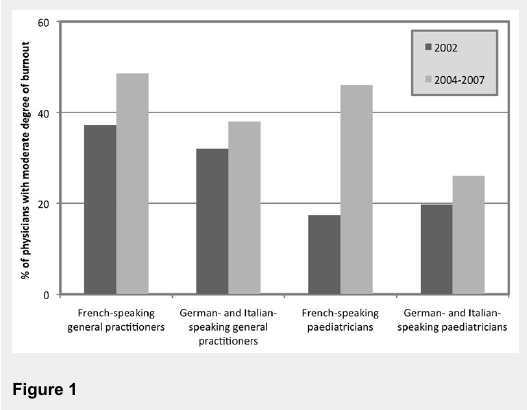
Figure 1 Trends of burnout among Swiss general practitioners and